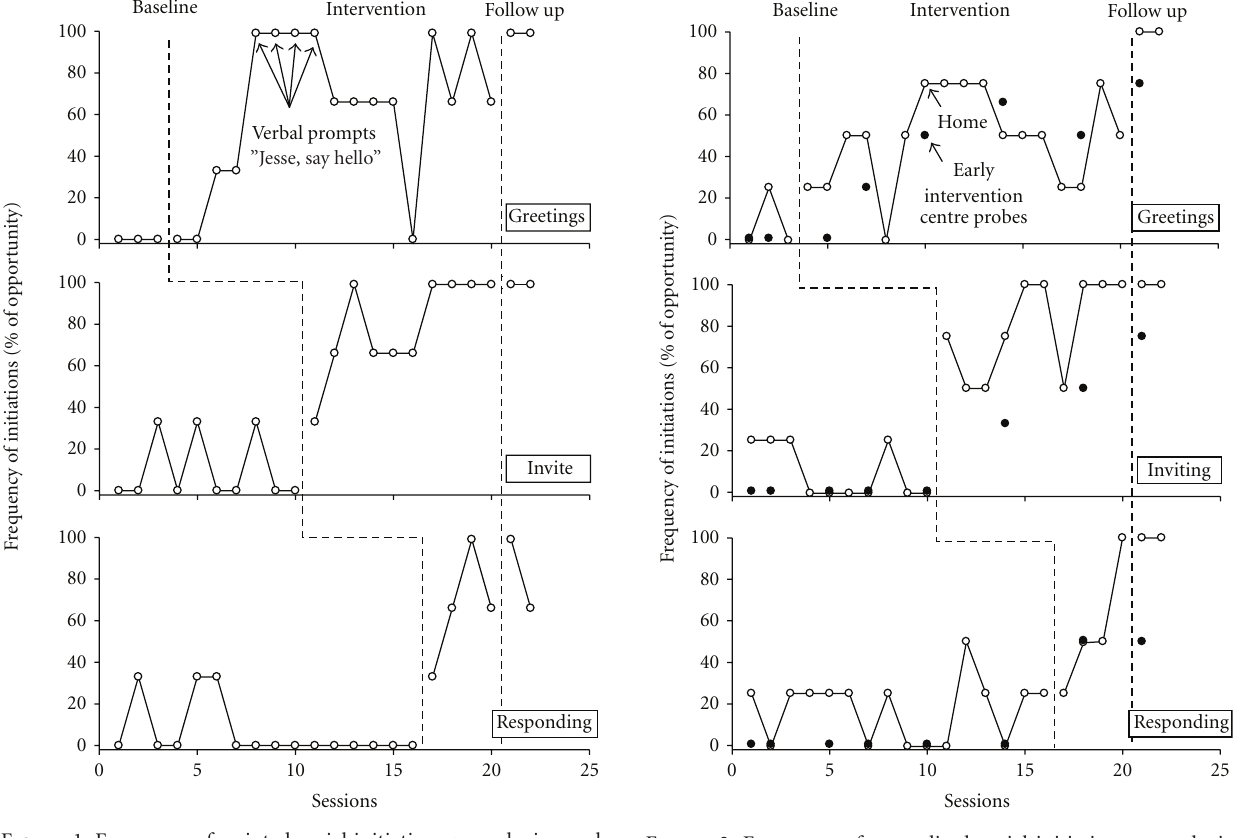
Figure 2: Frequency of generalised social initiations pre-, during and